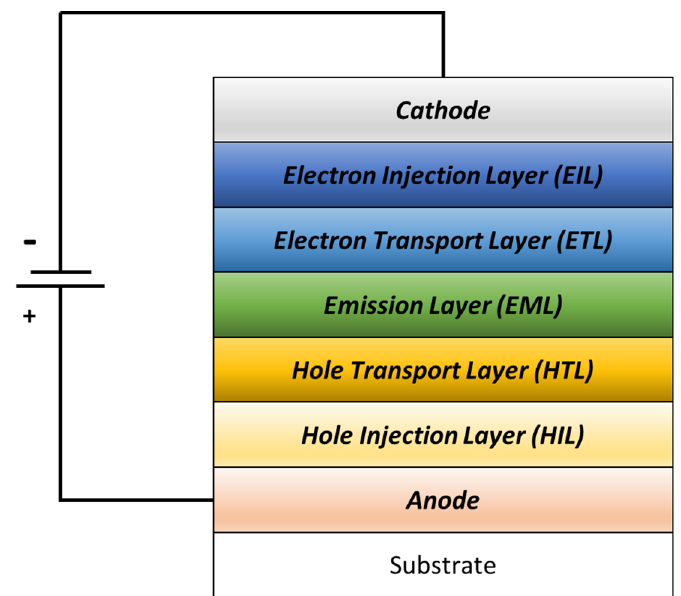
Figure 8. Schematic of the multilayers of an OLED structure.